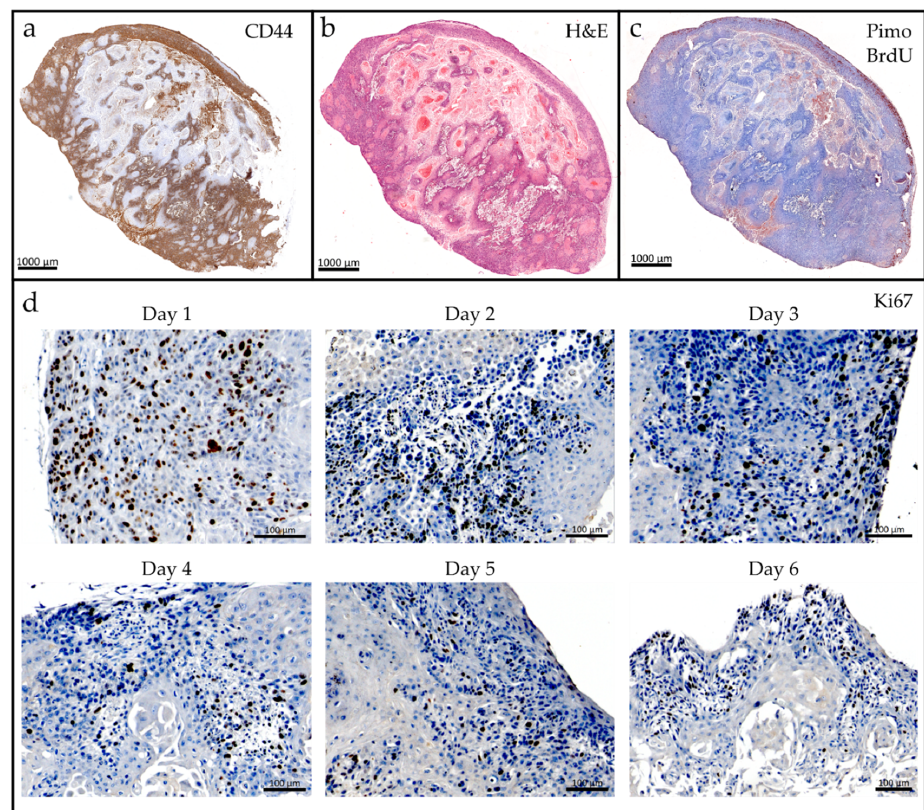
Figure 3. Histological analysis of tumor slice morphology and cell composition of a Cal33 squamous cell carcinoma of the head and neck (HNSCC) model. After two days in culture, tumor tissue contains ( a ) CD44 positive cells (brown), as well as ( b ) a necrotic fraction (light pink) located at the core of the tissue. ( c ) The center is hypoxic (red, pimonidazole), with proliferating cells (brown, bromodeoxyuridine (BrdU)) in the oxic rim. ( d ) Ki67 staining (brown) reveals cell proliferation across a culture period of six days. Counter staining with hematoxylin, blue cell nuclei. TSC were analyzed for biomarker changes following irradiation and along their physiological depth from skin to leg muscle. Neither the staining of total cells (DAPI), necrosis (H&E), or the CSC marker CD44 revealed significant differences between irradiated and control slices at 24 h post irradiation. However, independent of treatment, TSC maintained a typical tumor heterogeneity across the physiological tissue depth (Figure 4a). The necrotic fraction of tumor slices (49.5 ± 7.9%) correlated negatively with depth in the tissue (Pearson correlation R = −0.88, p < 0.01), CD44 expression (R = −0.61, p = 0.02) and the DAPI-positive area (R = −0.71, p < 0.01). Significant positive correlations were found between the CD44-positive staining and DAPI-positive area (R = 0.76, p < 0.01), tissue depth and CD44 (R = 0.67, p < 0.01), and depth and DAPI-positive area (R = 0.83, p < 0.01, n = 15, Figure 4b).